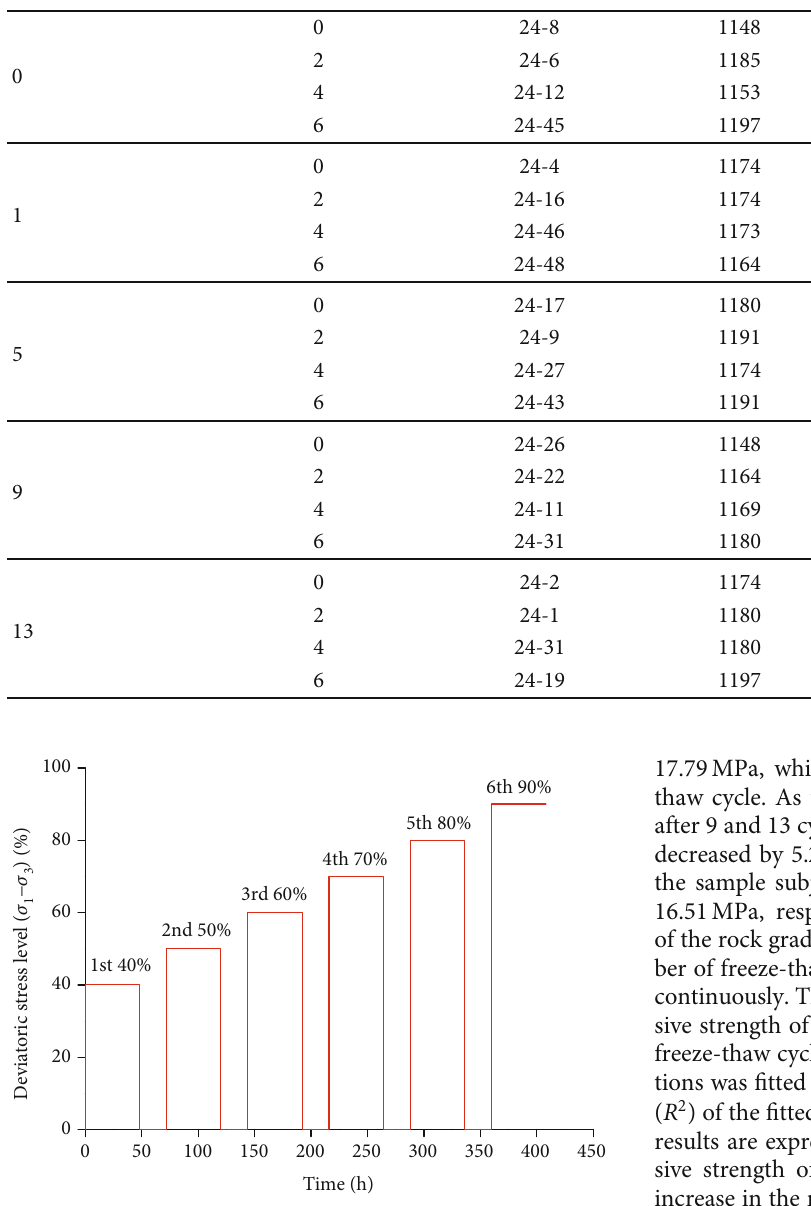
strength, con fi ning pressure, and number of freeze-thaw cycles, respectively.